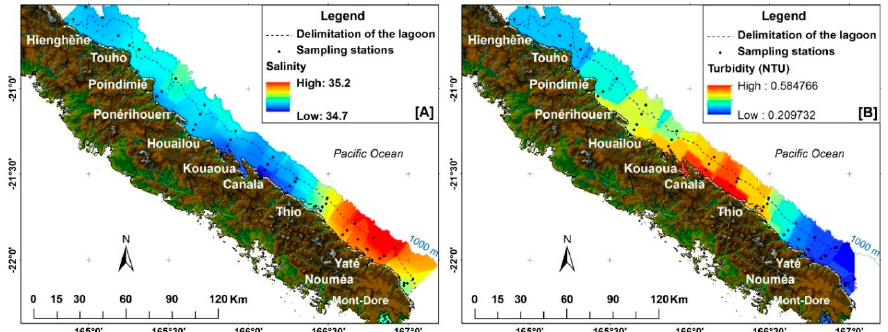
Figure 3. Surface distribution maps of the surface water salinity ( A ) and turbidity ( B ) in the ELNC, during CALIOPE 2 (March 2014) cruises.